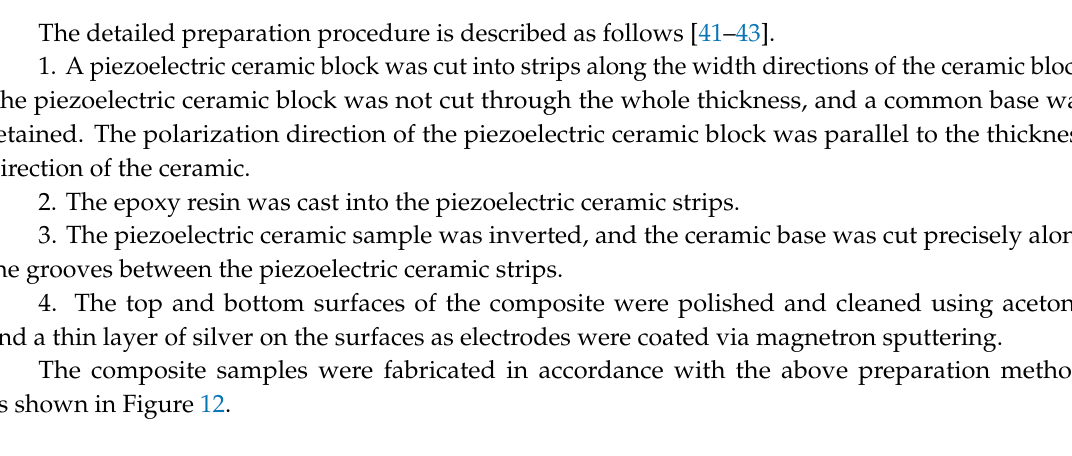
Figure 11. Preparation technology of the 2 ‐ 2 piezoelectric composite.